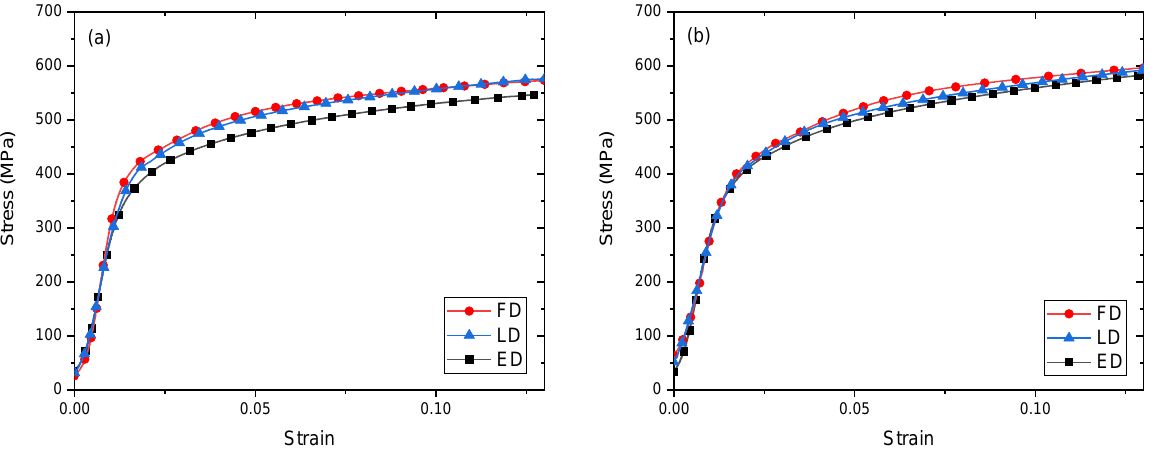
Figure 5. Compression stress-strain curves for Cu-Ta composites consolidated at 300 °C. For comparison, the stress strain curve for route 4E consolidation at ambient temperature is also shown.